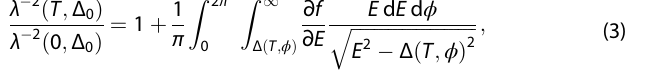
ð T Þ and λ (cid:3) 2 ð T Þ . Data are fi tted with a two gap ( s + s )- ab c